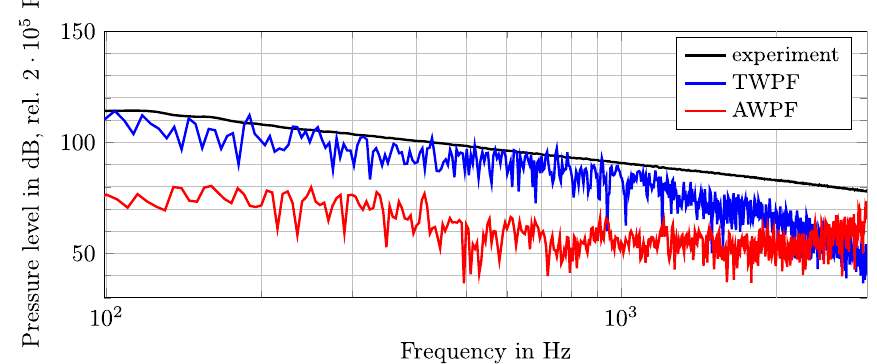
Figure 10. Comparison of acoustic (AWPF) and turbulent wall pressure fl uctuations (TWPF) with experimental data at center of side